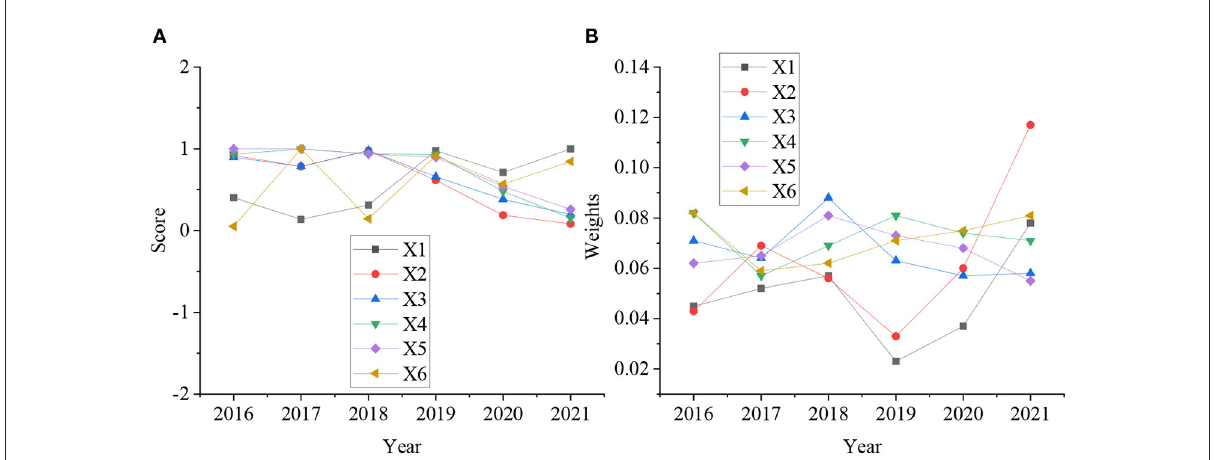
FIGURE4 Evaluation results of urban environmental health scores and weights [ (A) is environmental health assessment; (B) is environmental health